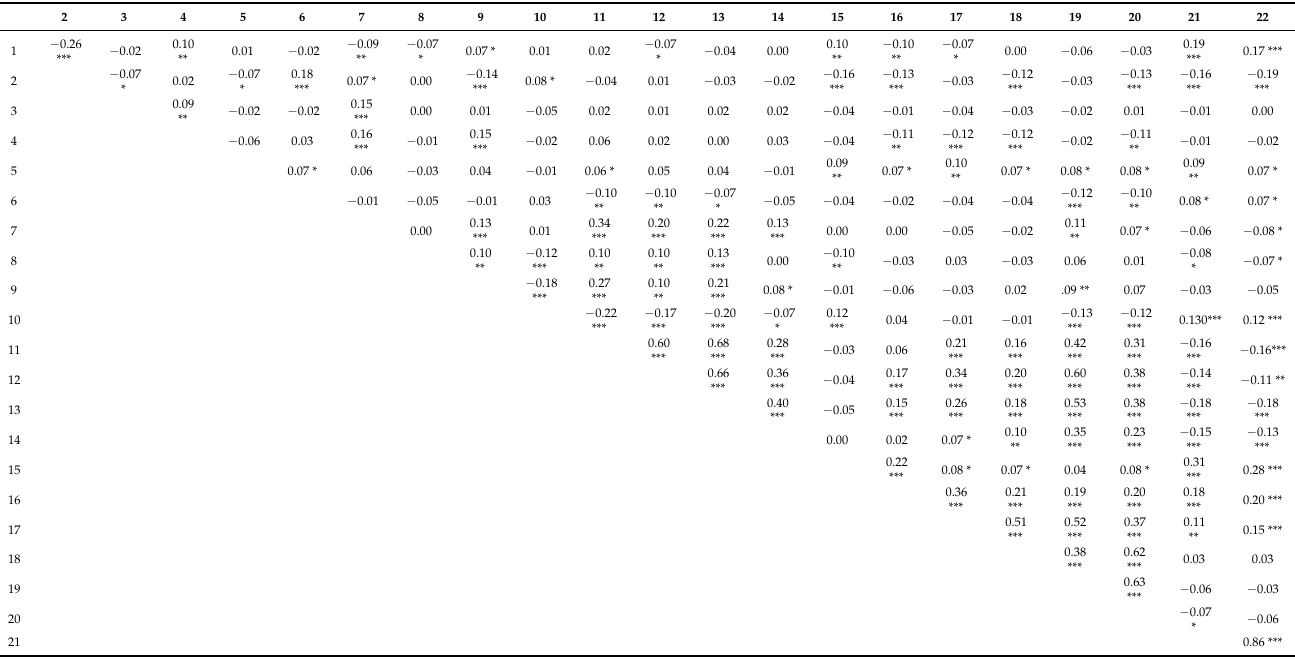
Table A2. Zero-order correlations for the analyzed variables.